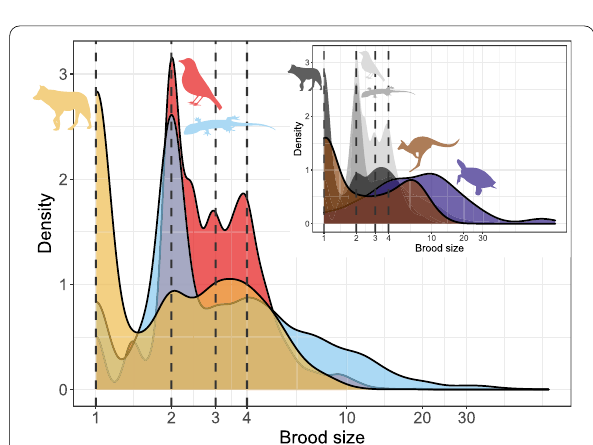
Fig. 5 Brood size. Red: birds; blue: squamates; purple: turtles; yellow: placental mammals; brown: marsupial mammals. Dashed vertical lines represent brood sizes of 1 (left-end), 2, 3 and 4. Note that the x axis is in log 10